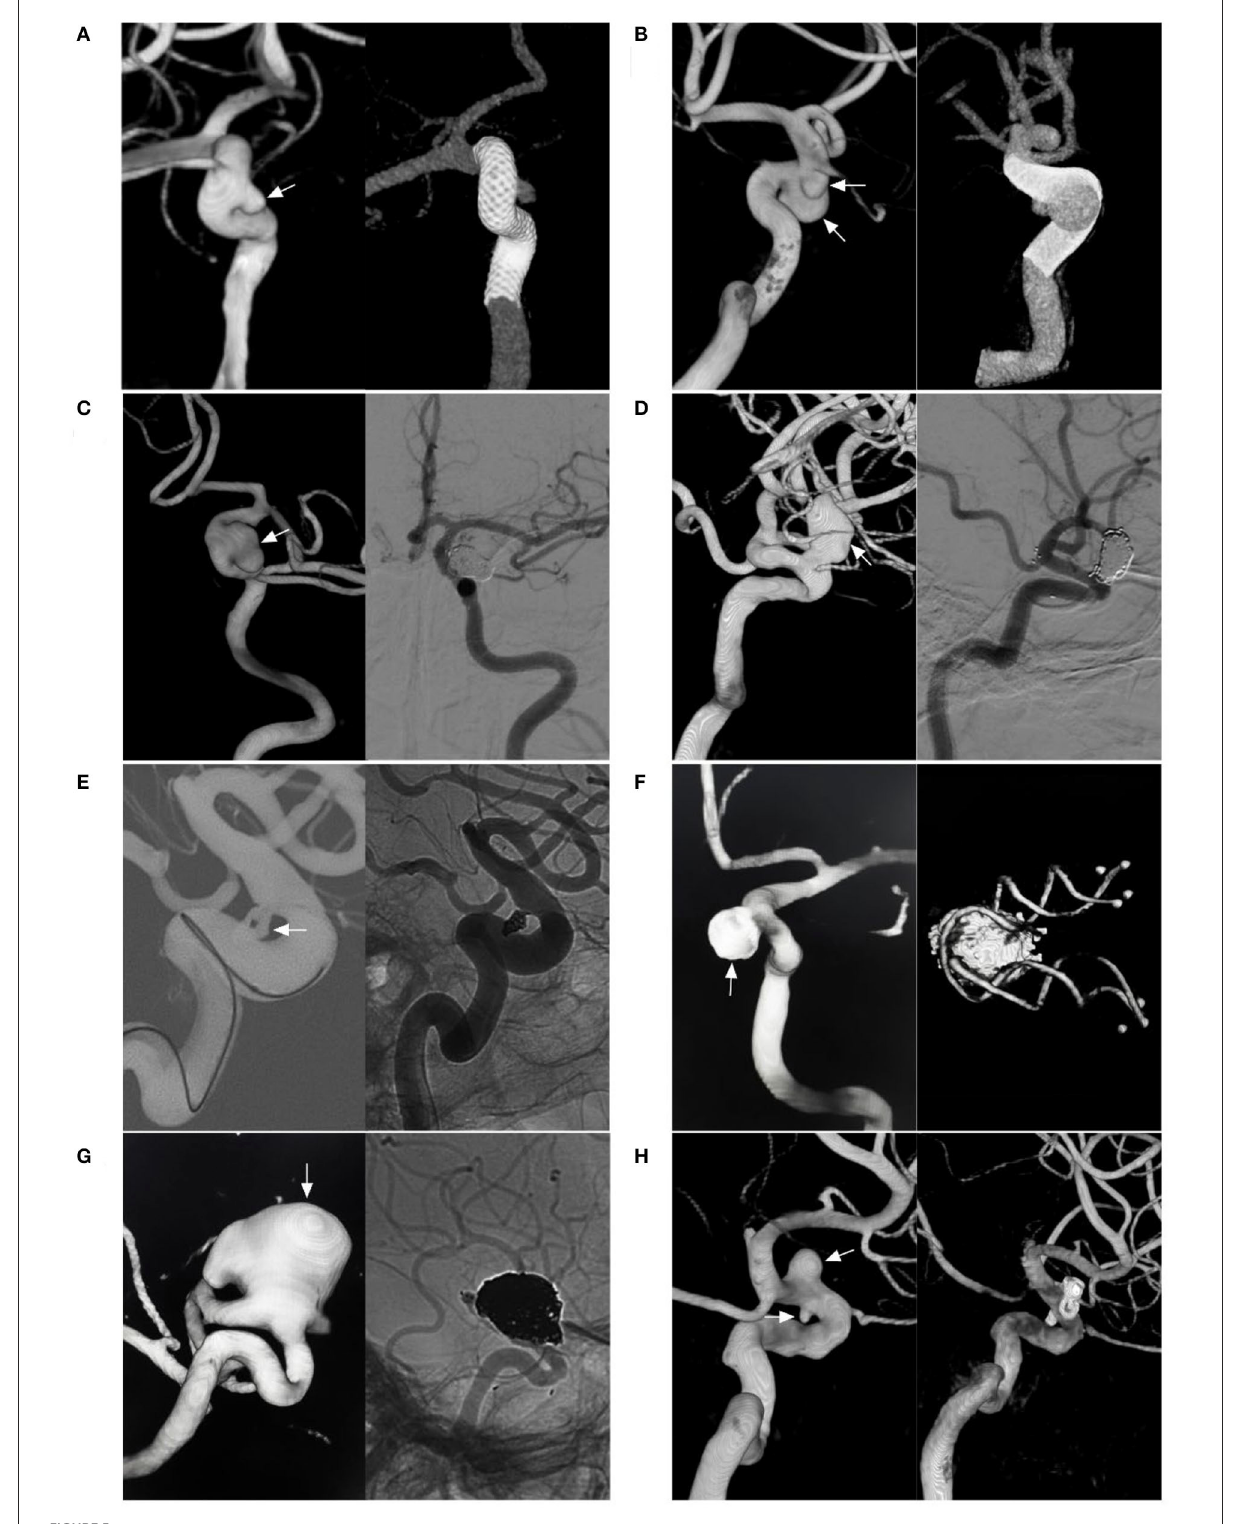
FIGURE5 Various EVT techniques for aneurysms of the paraophthalmic segment. (A) Left, three-dimensional DSA shows a carotid artery aneurysm (arrow); right: Vaso CT shows the FDS covering the aneurysm. (B) Left, three-dimensional DSA shows two aneurysms (arrows) of the paraophthalmic segment; right: Vaso CT shows the FDS covering two aneurysms. (C) Left, three-dimensional DSA shows a clinoidal aneurysm